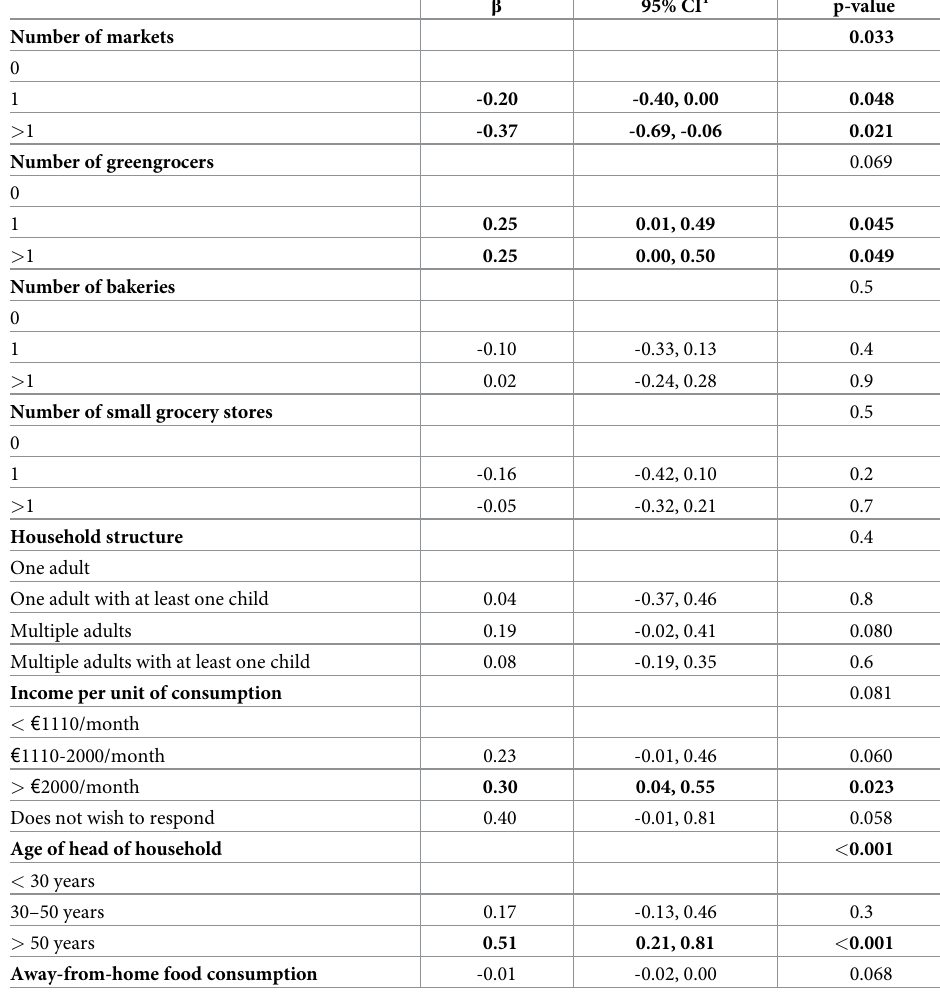
Table 2. Adjusted multilevel model of the associations between number of food outlets around the home and the nutritional quality of food purchases (r-HPI z-score) (N = 462). β 95% CI 1 p-value Number of markets 0.033